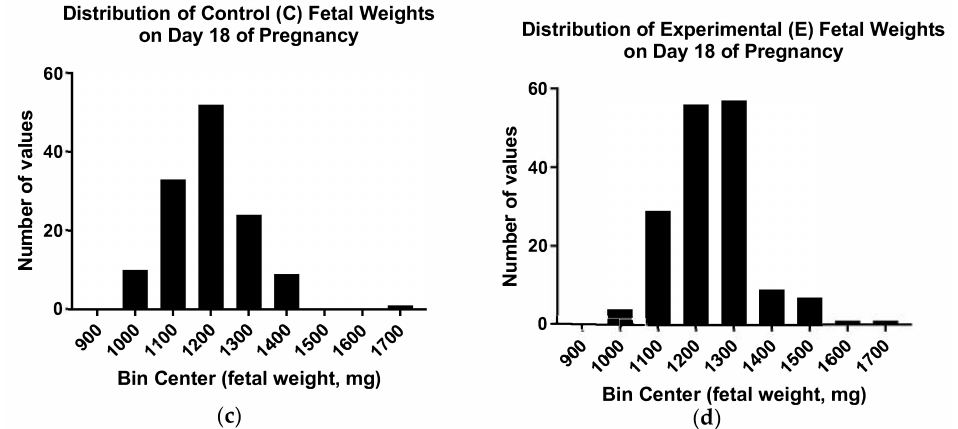
Figure 3. The experimental (E) fetuses were significantly smaller than the normal, control (C) fetuses on day 15 of pregnancy ( a ; t-test, p < 0.0001), but they were larger than normal on day 18 ( b ; t-test, p < 0.0001). Double asterisks (**) indicate mean values that are significantly di ff erent from each other. Also shown are the distributions of weights on day 18 for the control (C, c ) and experimental (E, d ) fetuses. (See Figure 2 for sample sizes).